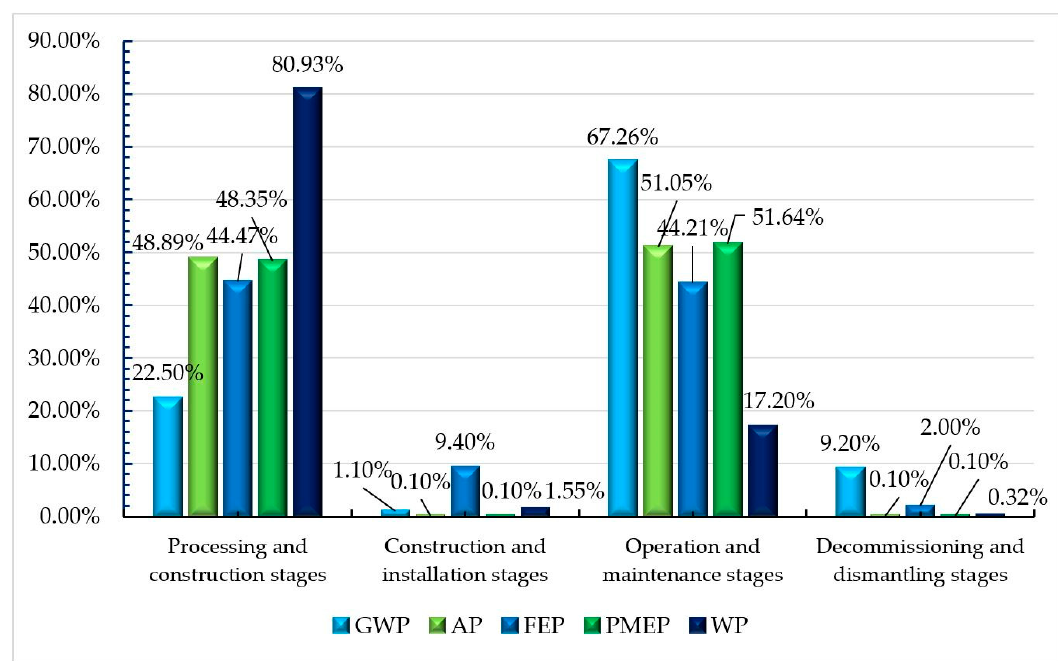
Figure 9. Schematic diagram of the environmental impact contribution of the four-stage cable-stayed bridge.